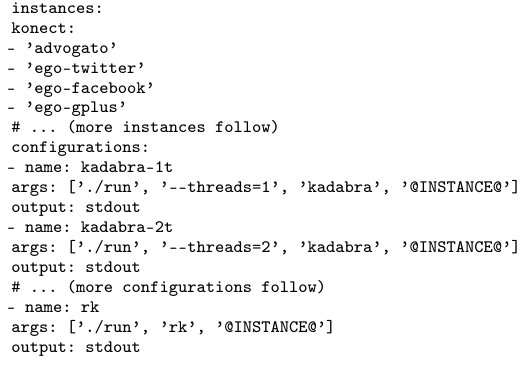
Figure 2. SimexPal configuration ( experiments.yml ) for KADABRA